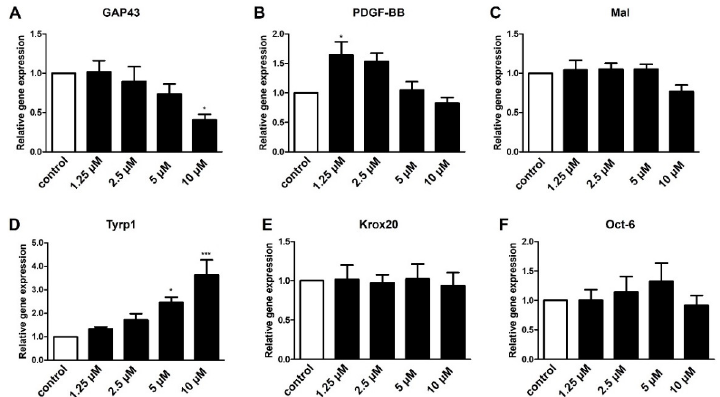
Figure 6. S1P4 plays only a minor role in Schwann cell transdifferentiation. Incubation with an agonist targeting S1P4 (CYM50260) led to a concentration-dependent downregulation of GAP43 ( A ) and an induction of PDGF-BB ( B ) and Tyrp1 ( D ) whereas Mal ( C ), Krox20 ( E ) and Oct-6 ( F ) were not affected by S1P4 modulation. For statistical analysis, a one-way ANOVA with Dunnett’s multiple comparison test was used, * p < 0.05, *** p < 0.001 ( n = 3–4). Shown are the mean values ± SEM.